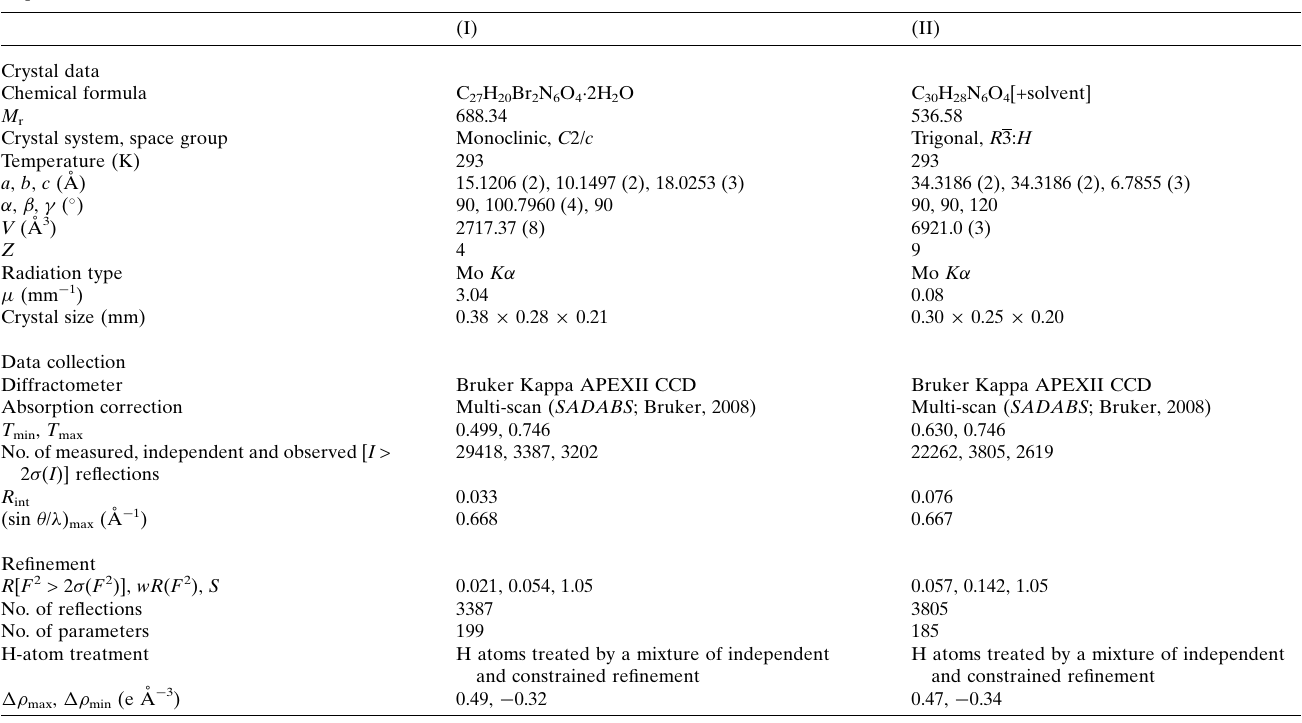
Table 5 Experimental details.